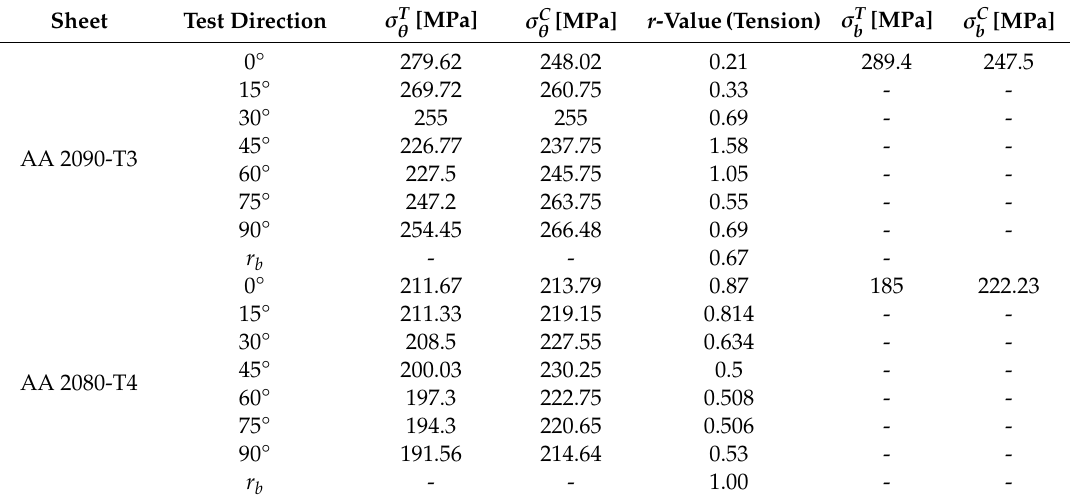
Table 1. Data for AA 2090-T3 and AA 2008-T4 sheets in tension and compression, adapted from [28,29], with permission from Elsevier, 2000 and 1995, respectively.